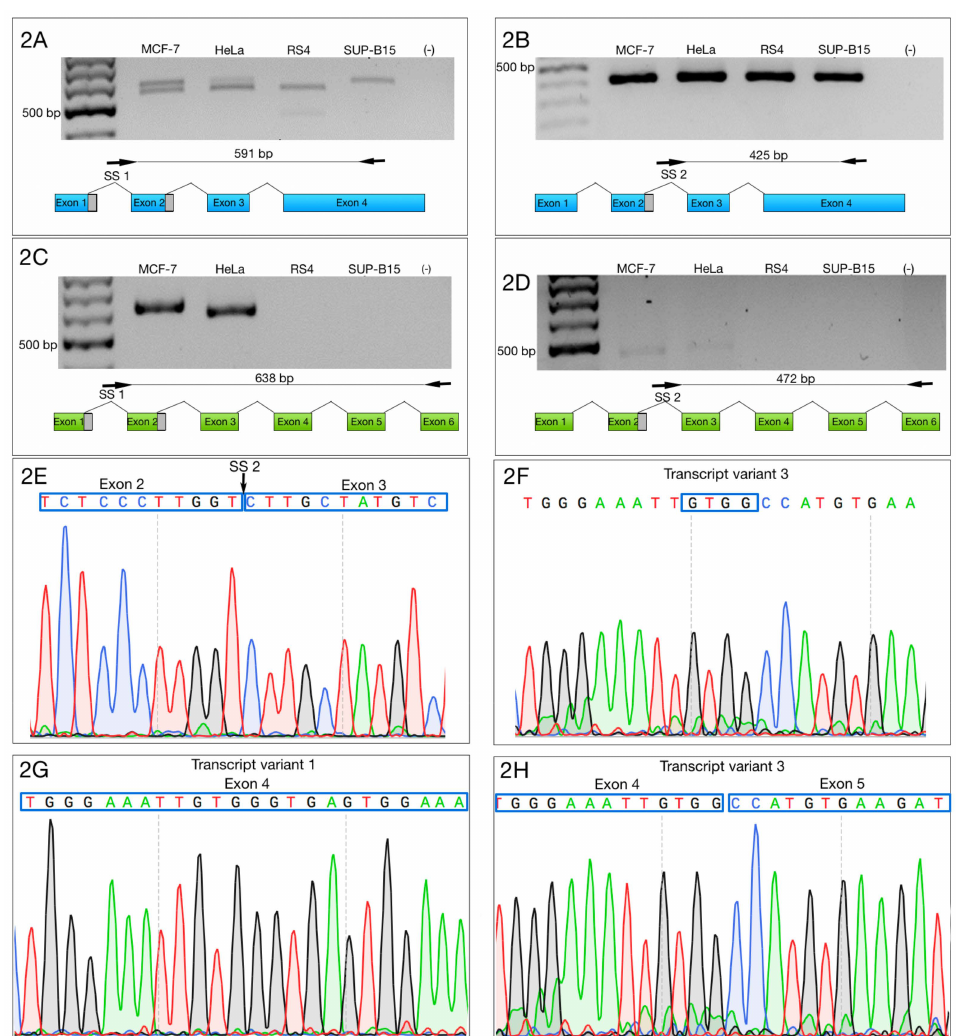
Figure 2. Selective amplification of ZNF695 alternative transcript variants. We selectively amplified the transcript variants of ZNF695. The black arrow and the black line indicate the sites of amplification and the PCR product size, respectively. The blue box indicates the full length of the long transcript of ZNF695 (TV1), the green box represents the short transcript of ZNF695 (TV3) and the grey box indicates the spliced region in the transcript. ( A ) Amplification of ZNF695_TV4 (591 bp) and ZNF695_TV5 (561 bp), which were co-expressed in the MCF-7 and HeLa cell lines. We observed that RS4 and SUP-B15 only expressed one variant, TV5 and TV4, respectively. ( B ) Specific amplification of ZNF695_TV5 of 425 bp in the four cell lines. ( C ) Amplification of ZNF695_TV6 (638 bp) in the MCF-7 and apparently HeLa cell lines expressed a preference for a TV7 of 608 pb. ( D ) Expression of ZNF695_TV7 (472 bp) was low in the MCF-7 and HeLa cell lines. We observed that in the HeLa cell line the amplified fragment showed bigger size than MCF-7. However, the sequences obtained from both fragments showed no di ff erence. ( E ) Sequence of SS2 of the amplified ZNF695 transcript variants. The blue boxes show the boundary (exon 2–3) of the AS site. ( F ) Sequence that confirms the identity of ZNF695_TV3. ( G ) Partial sequence that confirms the identity of ZNF695_TV1 (NM_020394.5). ( H ) Partial sequence that confirms the identity of ZNF695_TV3